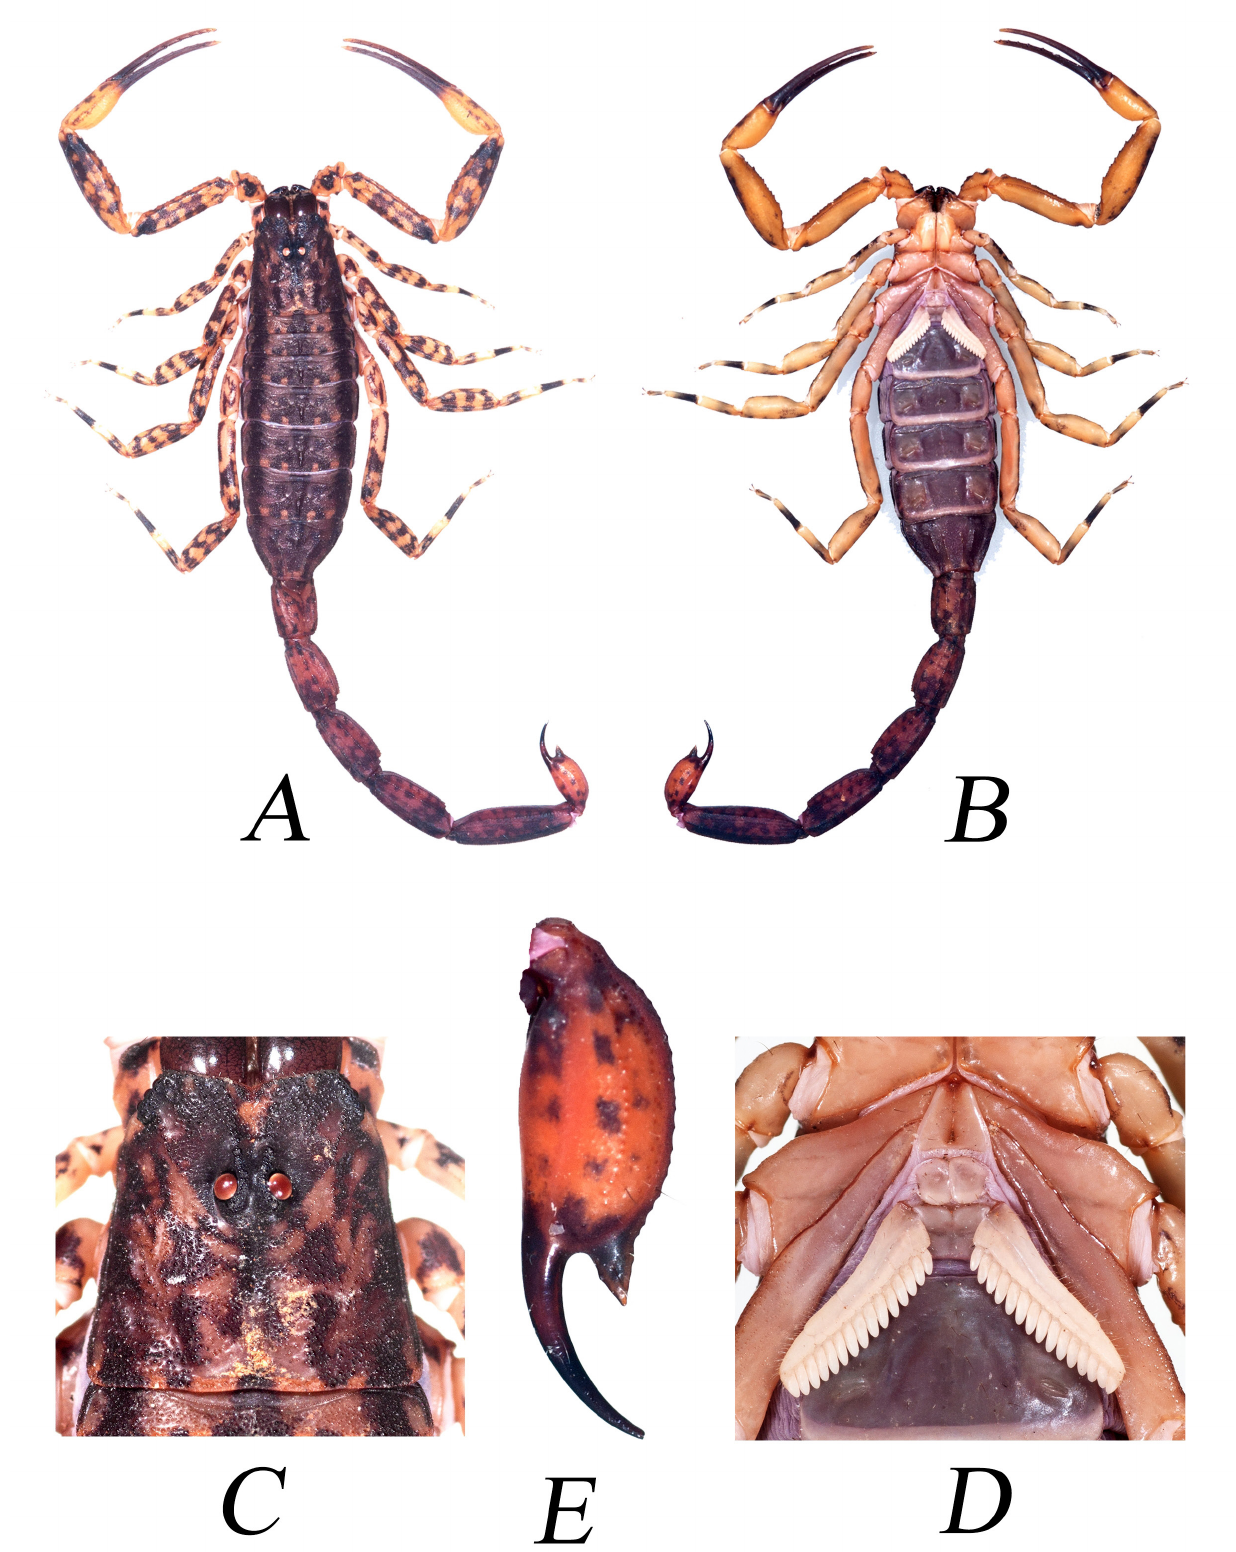
Fig. 11. Isometrus nakshatra sp. nov., paratype, adult ♀ (BNHS SC 196). A . Dorsal view. B . Ventral view. C . Carapace, dorsal view. D . Sternopectinal area. E . Telson, lateral